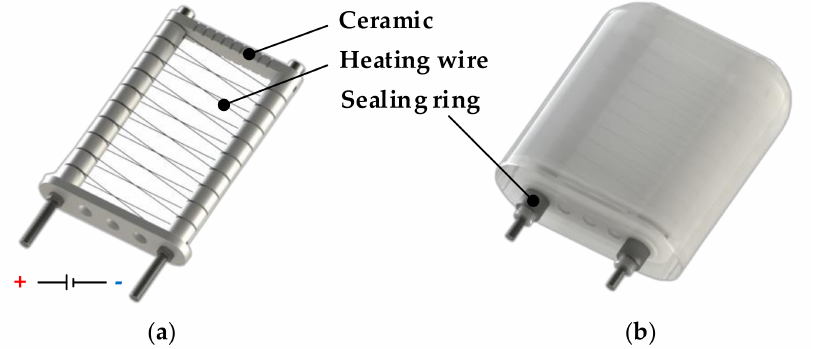
Figure 2. Design of heating device for para ffi n: ( a ) heating wire, supporting structure, and insulation structure of heating wire; ( b ) the layout of the heating device in the buoyancy adjustment module and the leakage proof structure of the module.